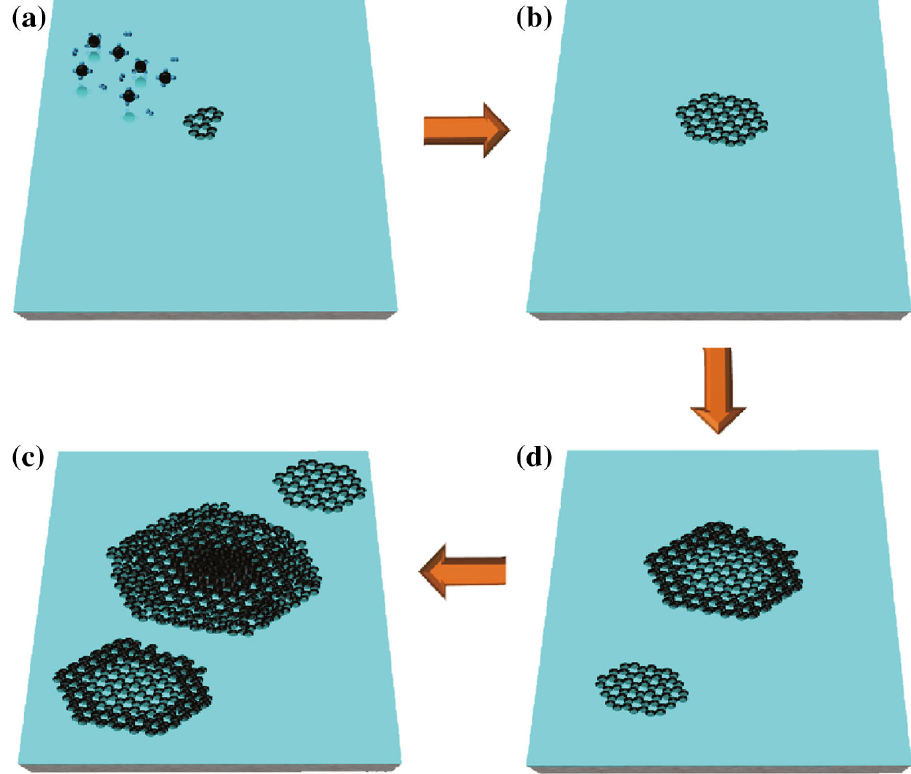
Fig. 5 Schematic of the direct nucleation and growth process of graphene domains on silicon substrates using metal-free APCVD. a Methane decomposition and super-saturated, active carbon species anchored on the silicon surface. This facilitates graphene nucleation. b In-plane propagation with carbon atoms landing at the edge of stable nuclei and the formation of small flat monolayer or bilayer graphene domains. c Edge-propagation process for bilayer graphene depositions at the active edge of the monolayer graphene domains, and the formation of larger, concave bilayer graphene domains. d Core-propagation process with more graphene layers nucleating in the core of the concave graphene domains, and stabilization of the bigger bulging graphene domains at higher growth